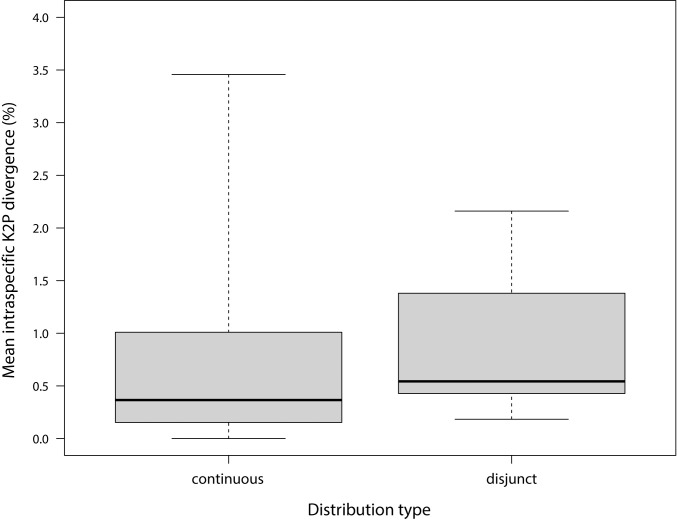
Mean intraspecific sequence divergences for 102 Lepidoptera species in different distribution types.Boxplot (median, interquartile range, total range) of total mean intraspecific sequence divergences (Kimura-2-Parameter) for 102 Lepidoptera species from Europe and South Siberia, comparing species with continuous versus disjunct distributions.